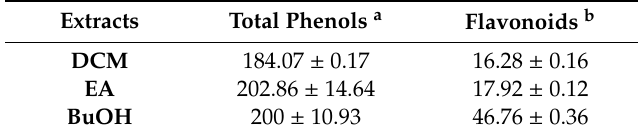
Table 4. Total phenolic and flavonoid contents of the extracts of H. laevigata var. hipponensis